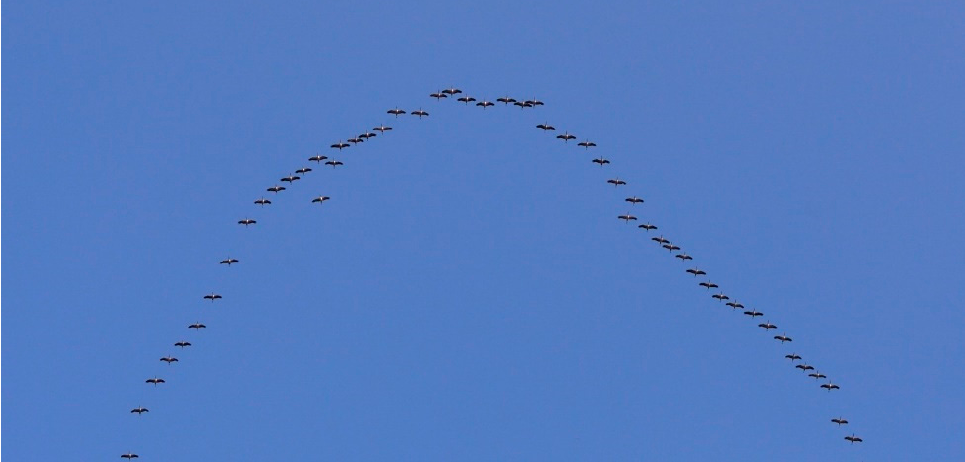
Figure 1. Migratory birds flying in a typical V-shaped formation (photography by Tobias Marks).